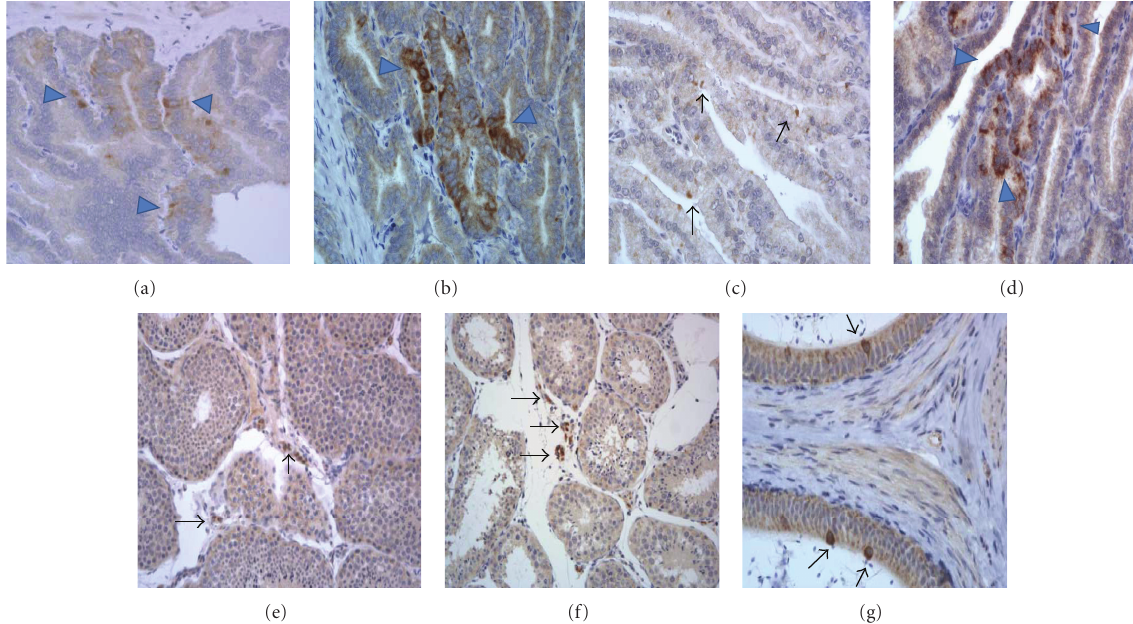
Figure 2: Detection of XMRV gag in the other reproductive tissues of the infected male macaques: seminal vesicle, ROu-4 ((a) day 7 pi), RLm-1 ((b) day 6 pi), RIl-10 ((c) day 291/133 pi), RLq-10 ((d) day 144 pi), testis, RIl-10 ((e) day 291/133 pi), testis, RLq-10 ((f) day 144 pi), epididymis, RLq-10 ((g) day 144 pi). Immunohistochemistry. Magnification, × 400 (a, b, c, d, g) and × 200 (e, f).